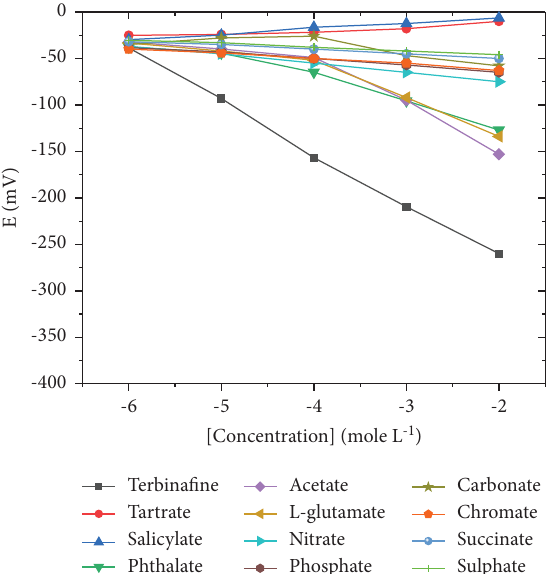
Figure 7: Potentiometric response of the microchip to terbinafne and diferent interfering